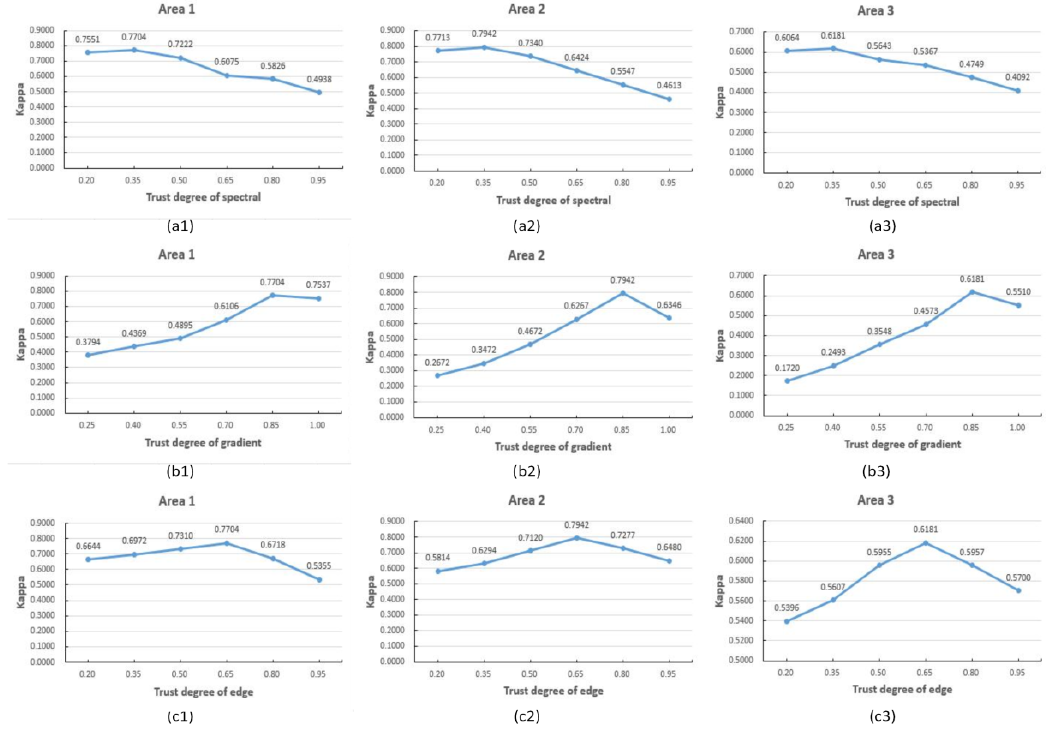
Figure 11. Influences of different trust degrees of features on method accuracy. ( a1 – a3 ) Influences of spectral trust degree in three experimental areas; ( b1 – b3 ) gradient trust degree; ( c1 – c3 ) edge trust degree. ( c1 ), ( c2 ), and ( c3 ) edge trust